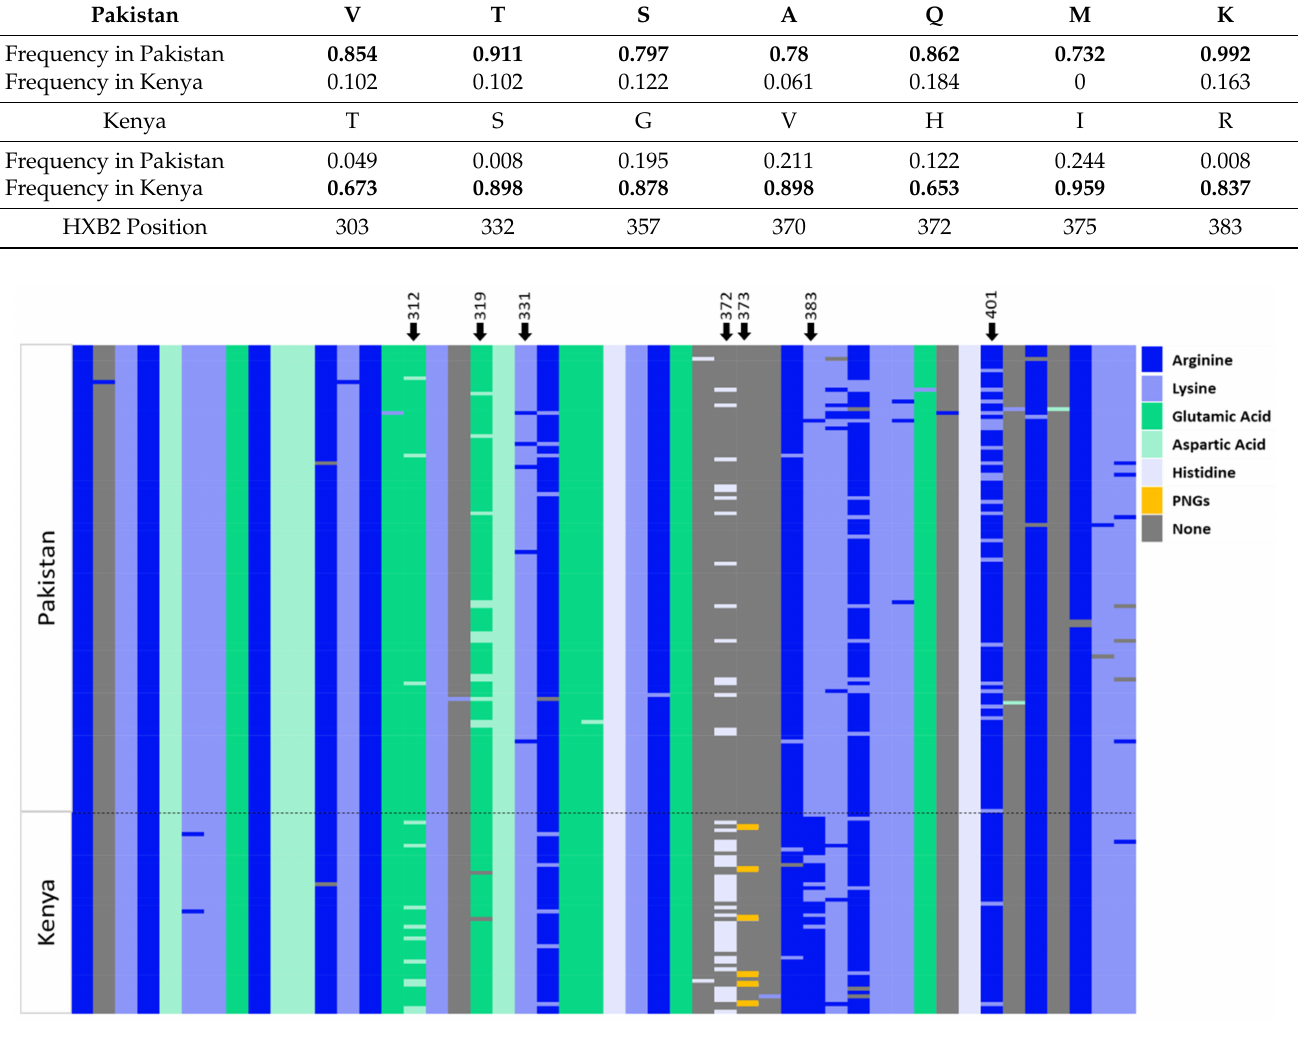
Figure 3. Biophysical properties of amino acids on sites of Kenyan and Pakistani HIV-1 sub-subtype A1 strain. Blue and light blue colors represent arginine and lysine amino acids, whereas the green and light green represent glutamic acid and aspartic acid, respectively. The black arrow represents sites with visible differences between the two